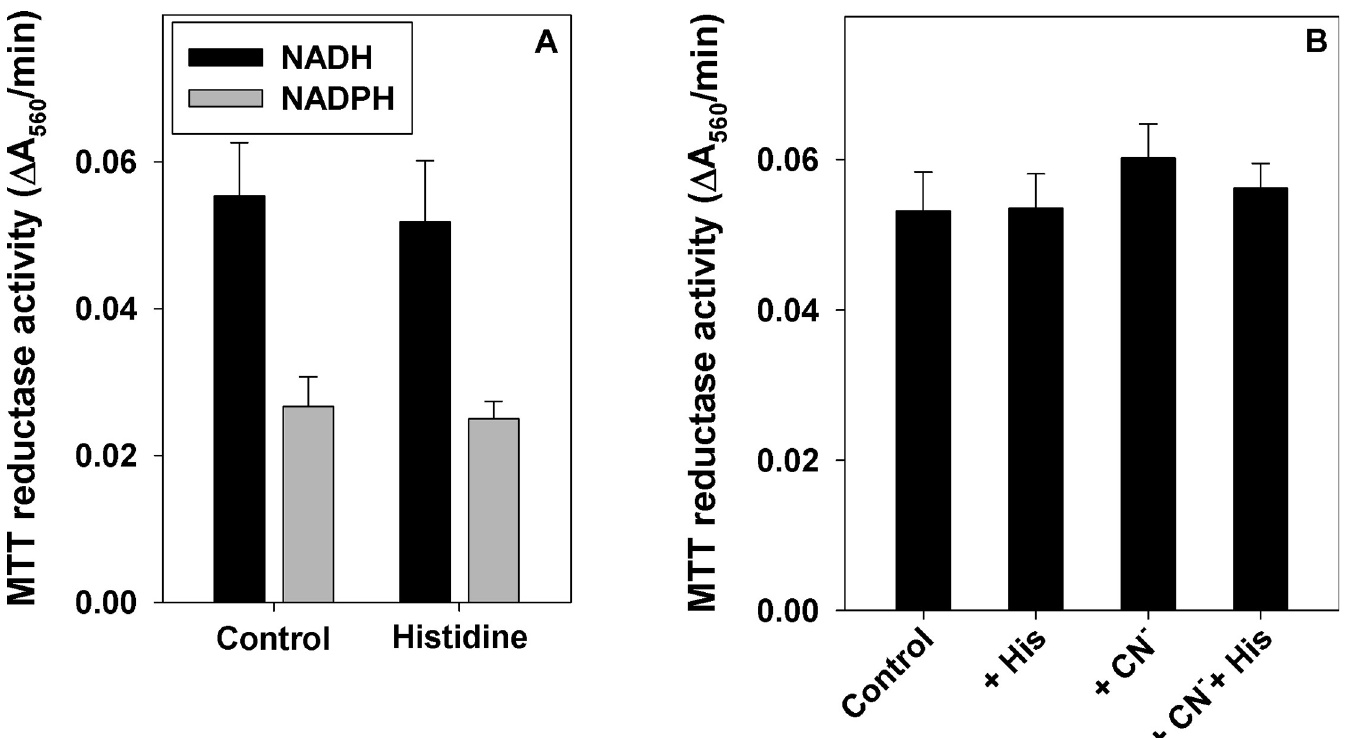
Fig 8. Reduction of MTT to formazan by cell-free extracts. Mid-log E . coli (OD 600 = 0.5) was incubated with or without 5.0 mM histidine for 60 min at 37 o C in PBS/ glucose. The cells were washed and disrupted by French press. MTT reductase activity was determined spectrophotometrically by measuring formation of formazan at 560 nm. Reaction mixture contained 0.5 mg MTT, and 3.5 mM NADH or NADPH in one ml of 50 mM phosphate buffer, pH 7.4. Reaction was started by adding cell- free extract. The experiment was repeated three times. Mean ± SD is presented.